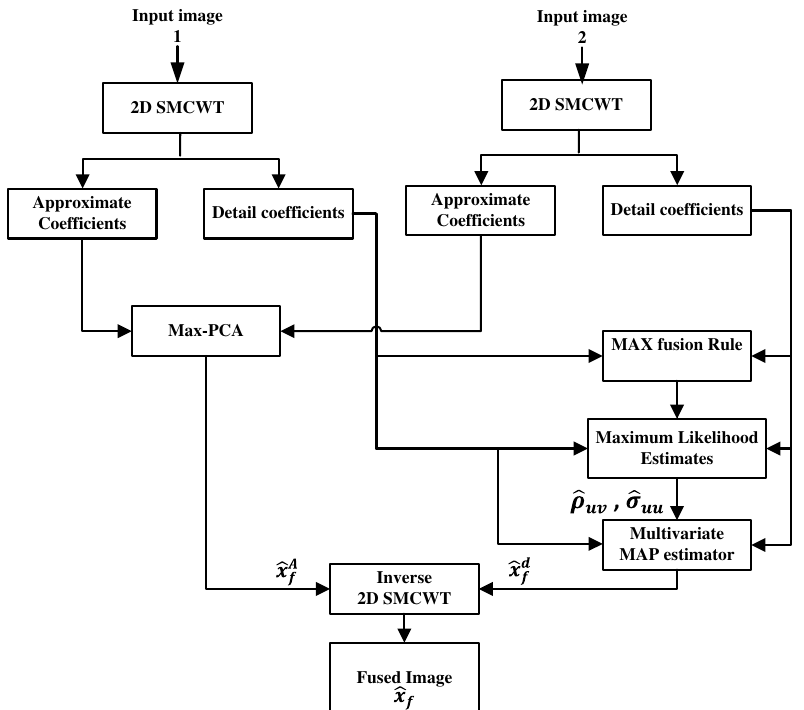
Fig. 2. Schematic diagram of the proposed fusion